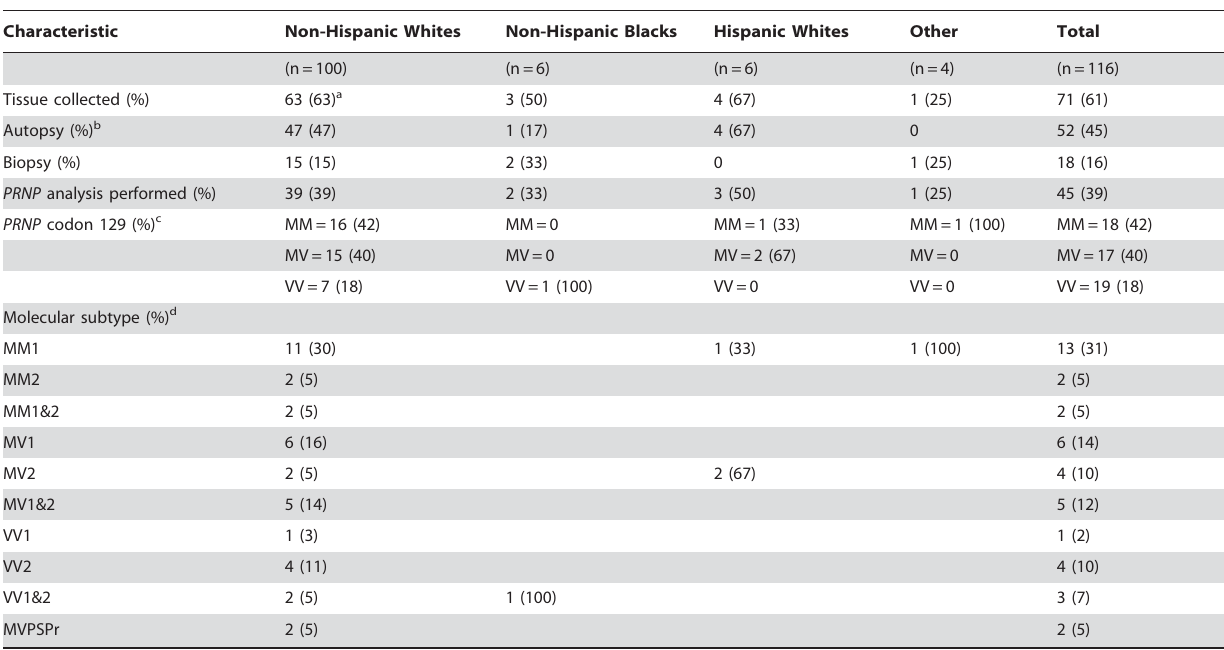
Table 5. Neuropathologic and molecular data of study subjects.